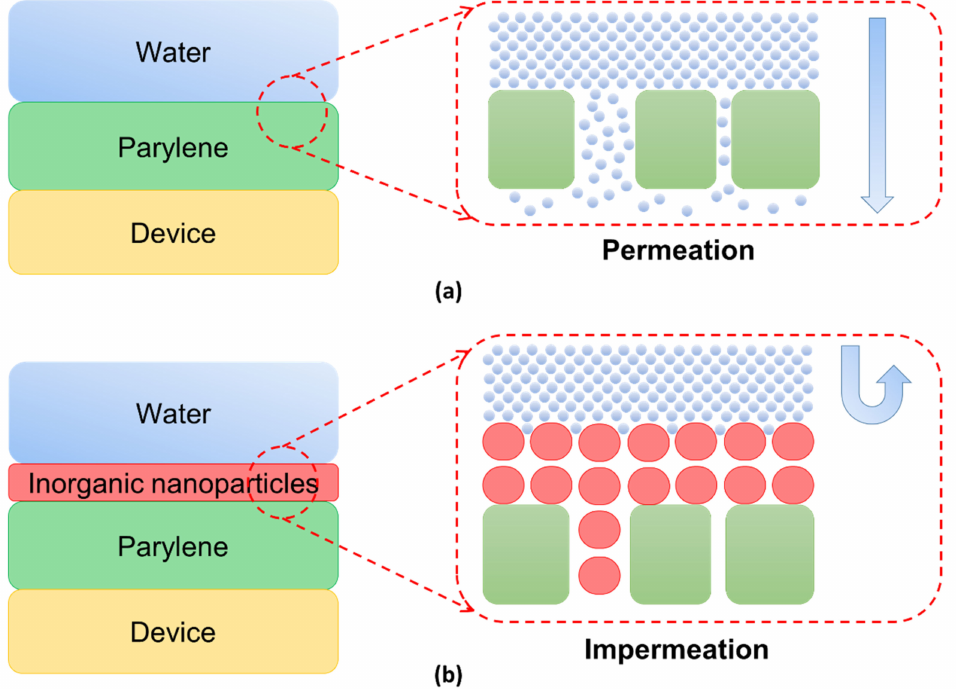
Figure 1. ( a ) Schematic diagram of water permeation of parylene encapsulation layer; ( b ) schematic diagram of waterproof permeation principle of defect filling method of micro-nano composite structure